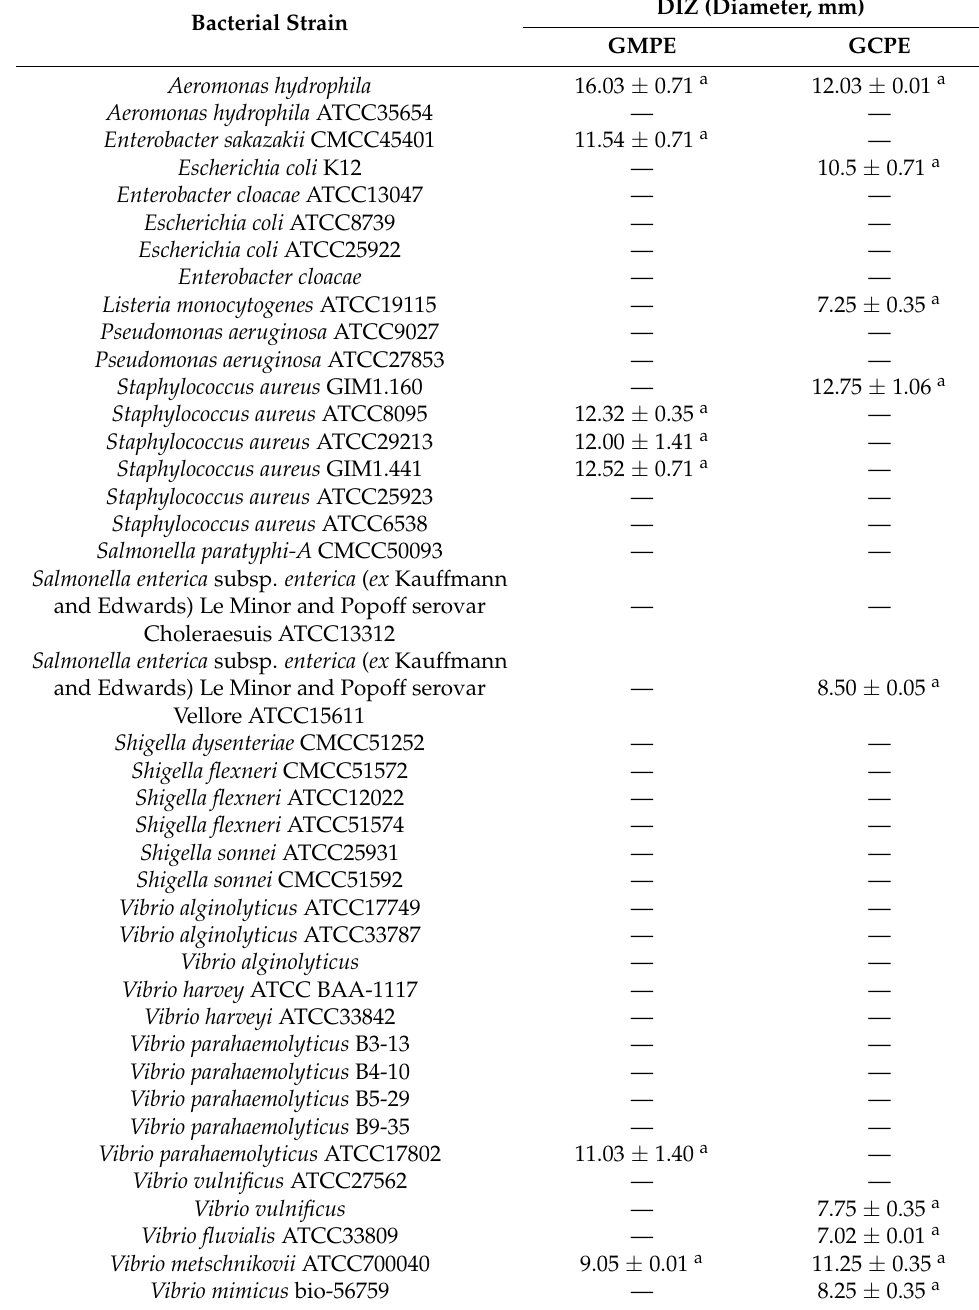
Table 1. Antimicrobial activity of the GMPE and